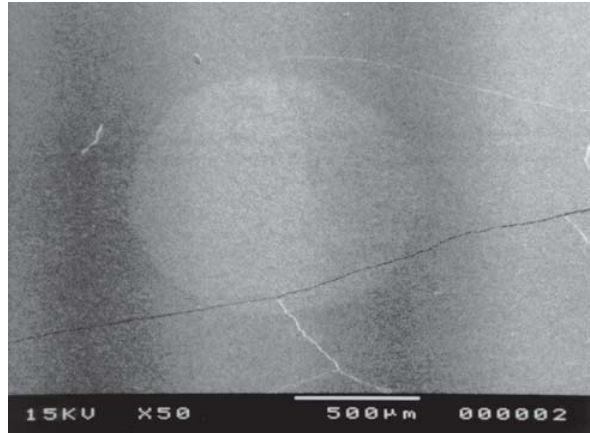
FIGURE 4- Scanning electron microscopy of sound enamel FIGURE 6- Scanning electron microscopy of demineralized enamel after prophylaxis with sodium bicarbonate jet - Group IV (Original magnification, X 50).